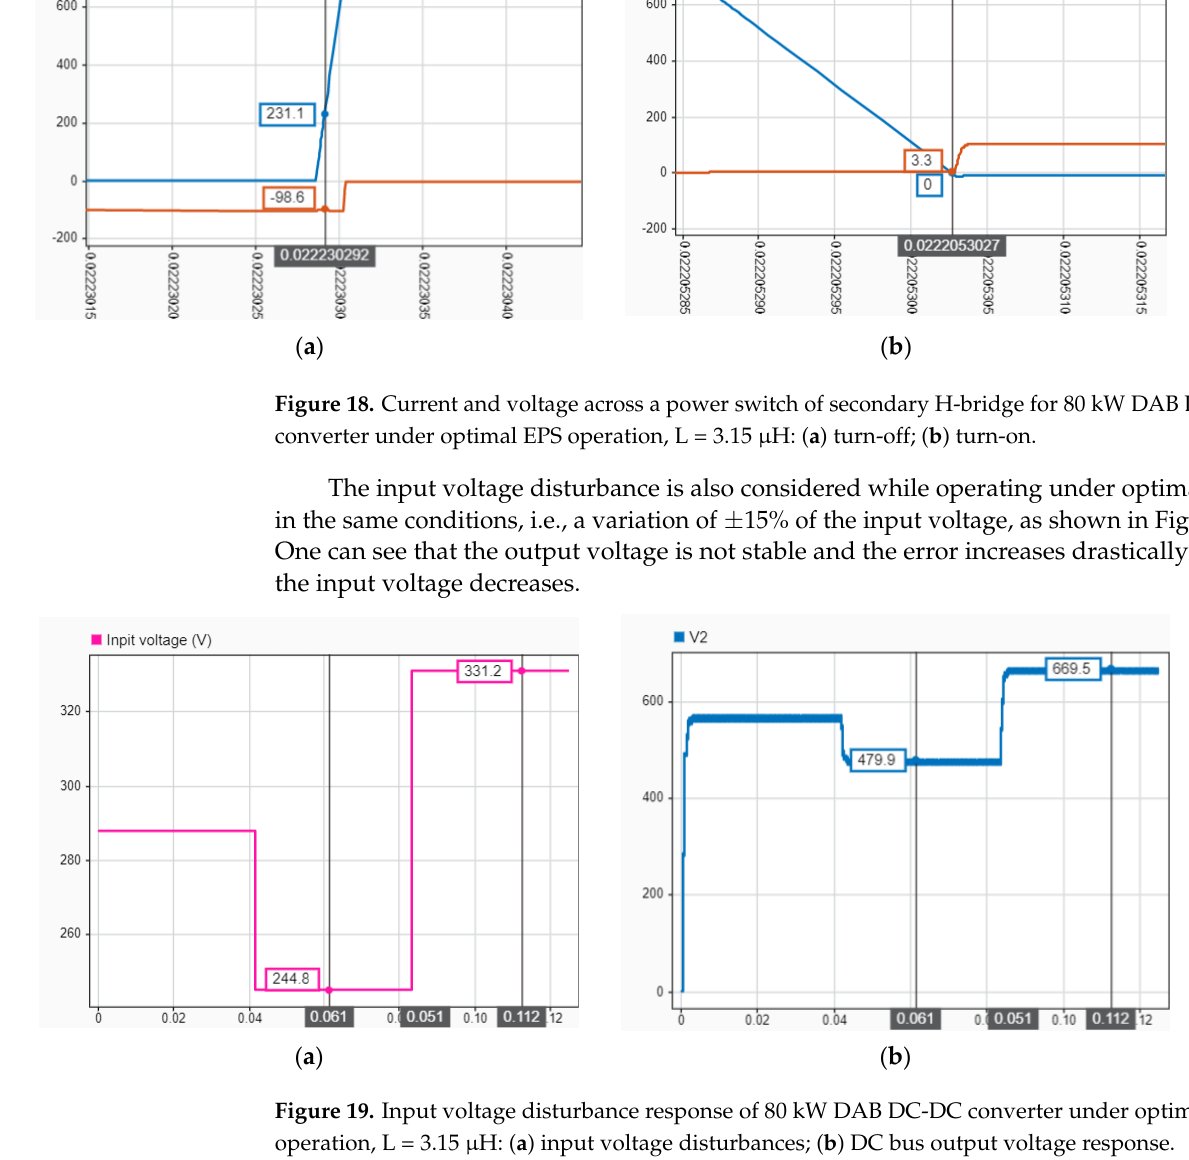
Figure 19. Input voltage disturbance response of 80 kW DAB DC-DC converter under optimal EPS operation, L = 3.15 µH: ( a ) input voltage disturbances; ( b ) DC bus output voltage response.